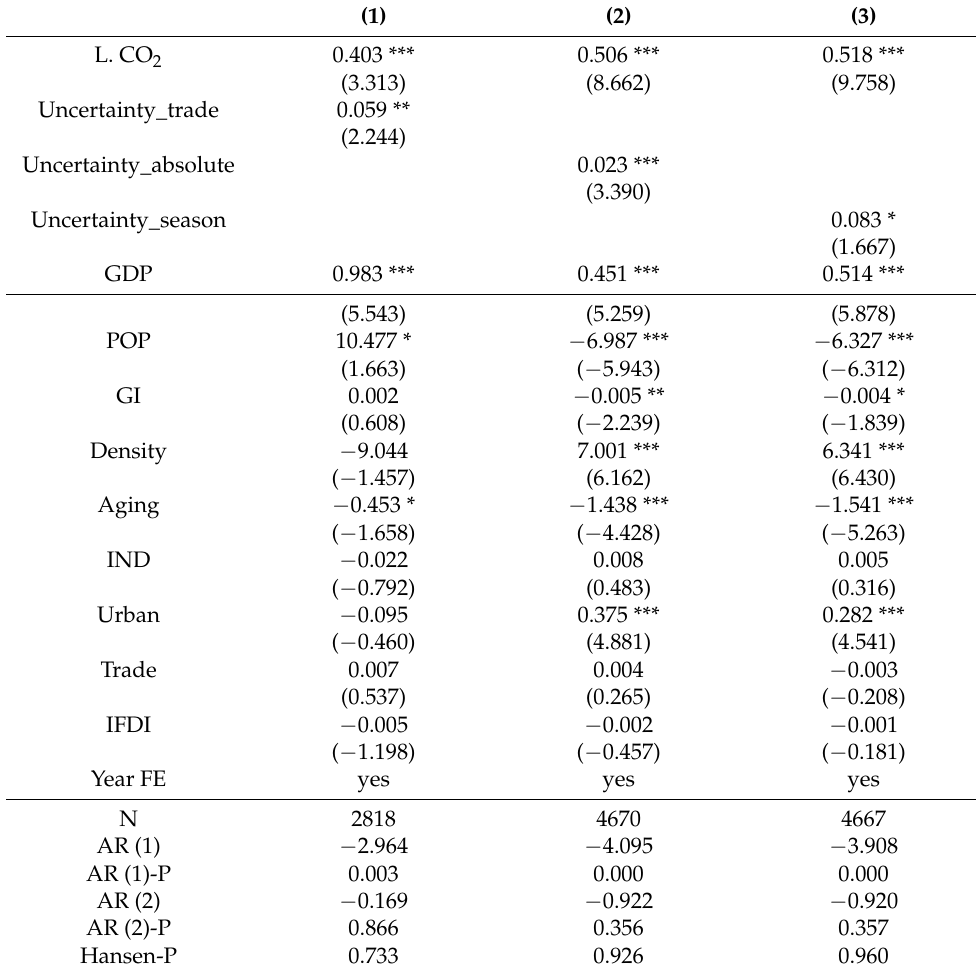
Table 4. Robustness test—changing the measurement of